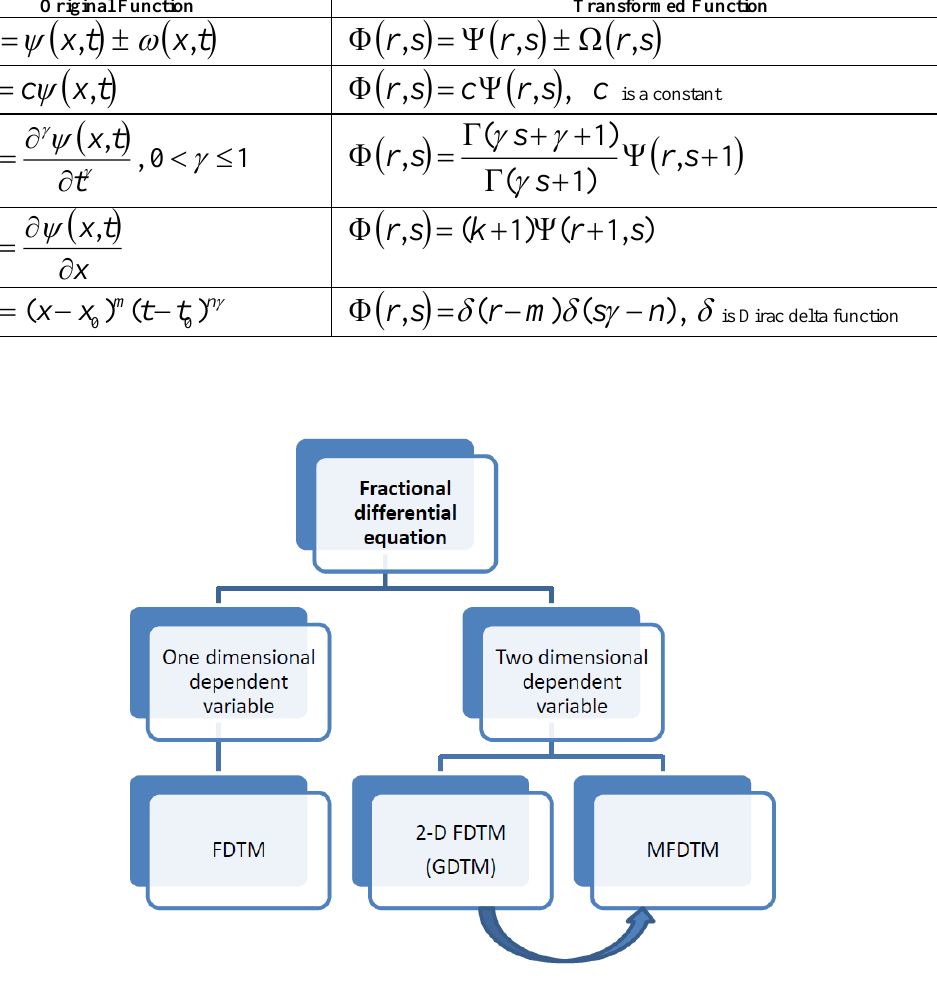
Figure 2. An overview of fractional differential transform